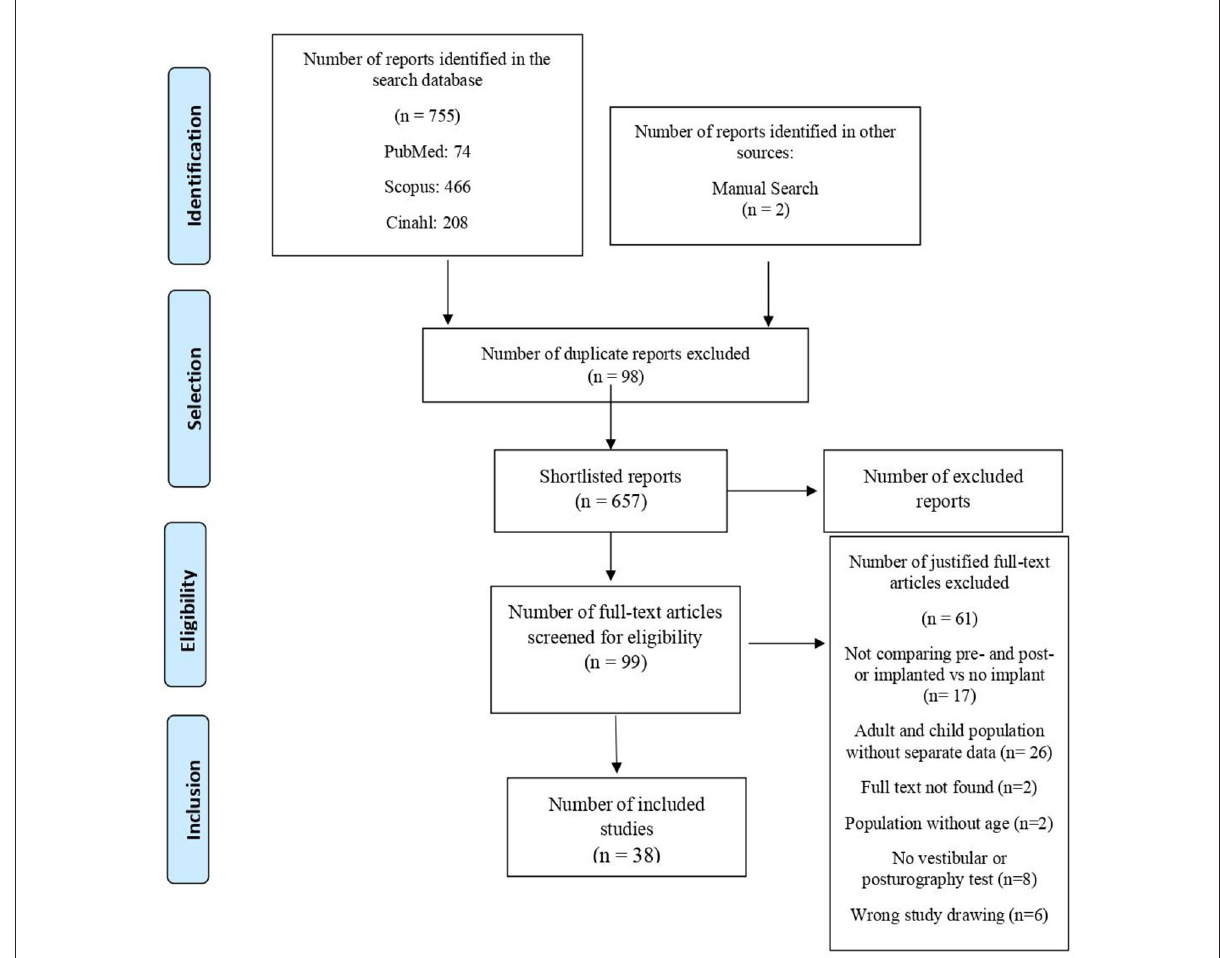
FIGURE1 Diagram of search and study selection process adapted from